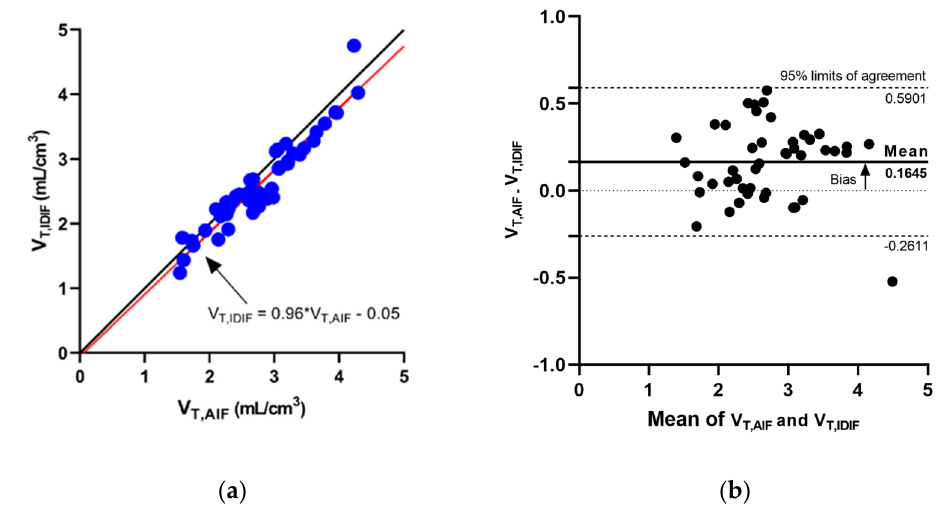
Figure 2. ( a ) The scatter plot for V T,IDIF plotted against V T,AIF . The dashed line is the unity line. The red line is the fitted regression trend line. The scatter plot shows a strong correlation between V T,IDIF plotted against V T,AIF . The statistical test also showed a strong correlation through the mixed effect model analysis. ( b ) The Bland–Altman plot for V T,IDIF and V T,AIF .